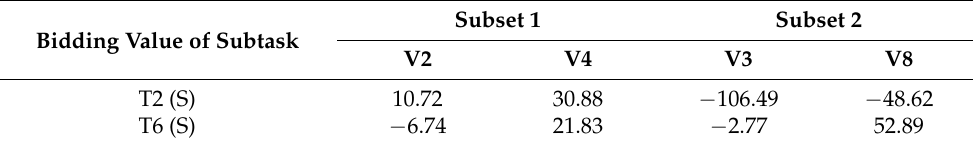
Table 9. The bidding values of potential bidders for dynamic subtasks.